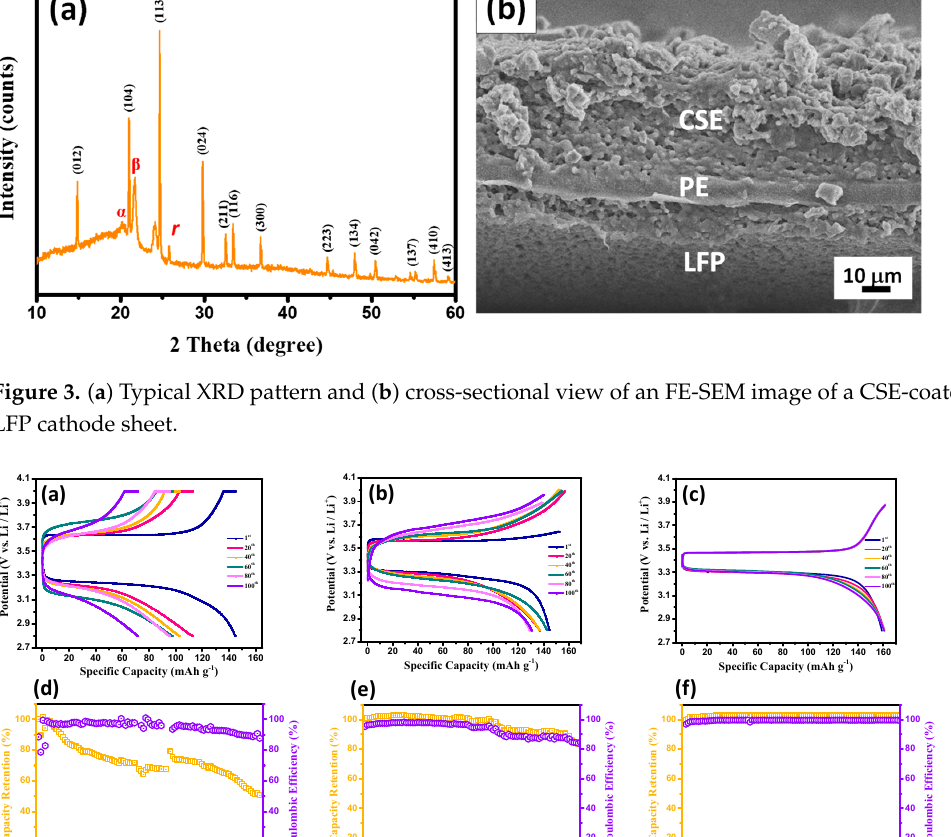
thicker CSE layers imparted longer diffusion pathways for the Li + ions. In particular, at performance of Li-metal batteries during long-duration cycling.